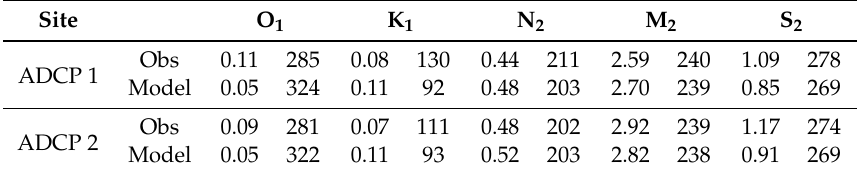
Table 2. Modelled and observed amplitude (m s ´ 1 ) and phase ( ˝ ) of the tidal velocities for the principal tidal